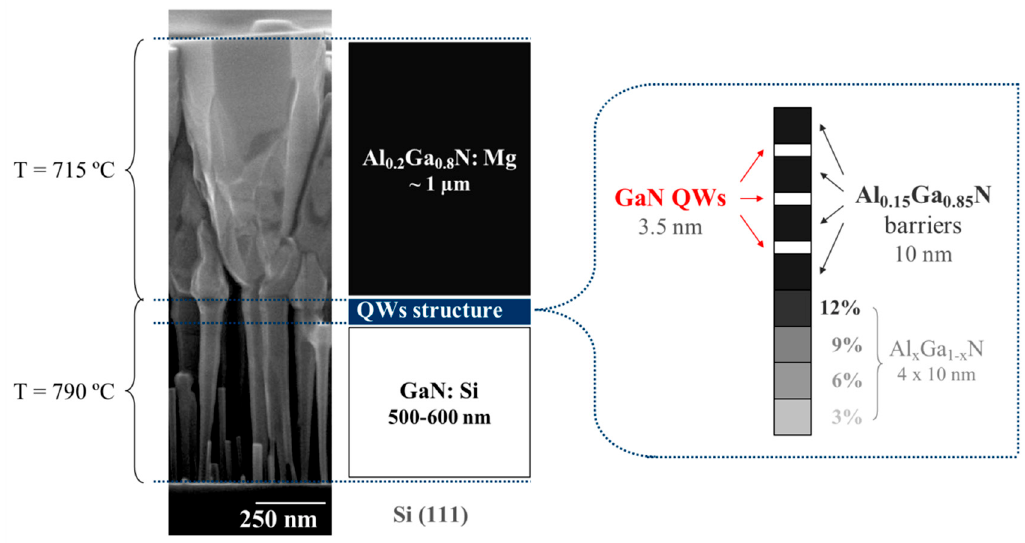
Figure 1. Scanning electron microscopy (SEM) image and scheme of the light emitting diode (LED) nanowire structure, which consists of: a GaN:Si n-type part on the bottom, an active region, which starts with AlGaN segments with an increasing Al content (3%, 6%, 9% and 12%), followed by 3 GaN quantum wells (QWs), which are sandwiched between the Al 0.15 Ga 0.85 N barriers and the p-type Al 0.2 Ga 0.8 N:Mg top.